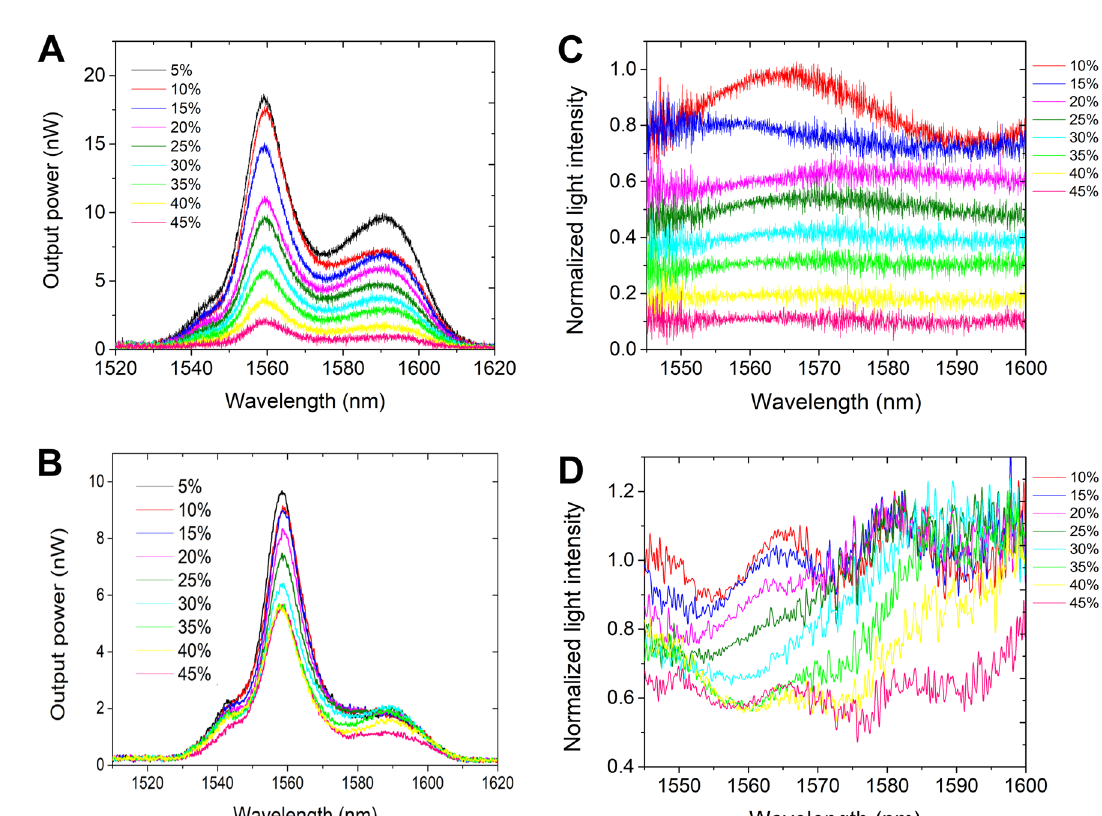
Figure 3. Optical spectra of bare TOF sensors in different mass fractions of glucose solutions. ( A ) TOF (Ø = 5 μm diameter) and ( B ) TOF (Ø = 12 μm diameter). ( C , D ) Corresponding normalized intensity